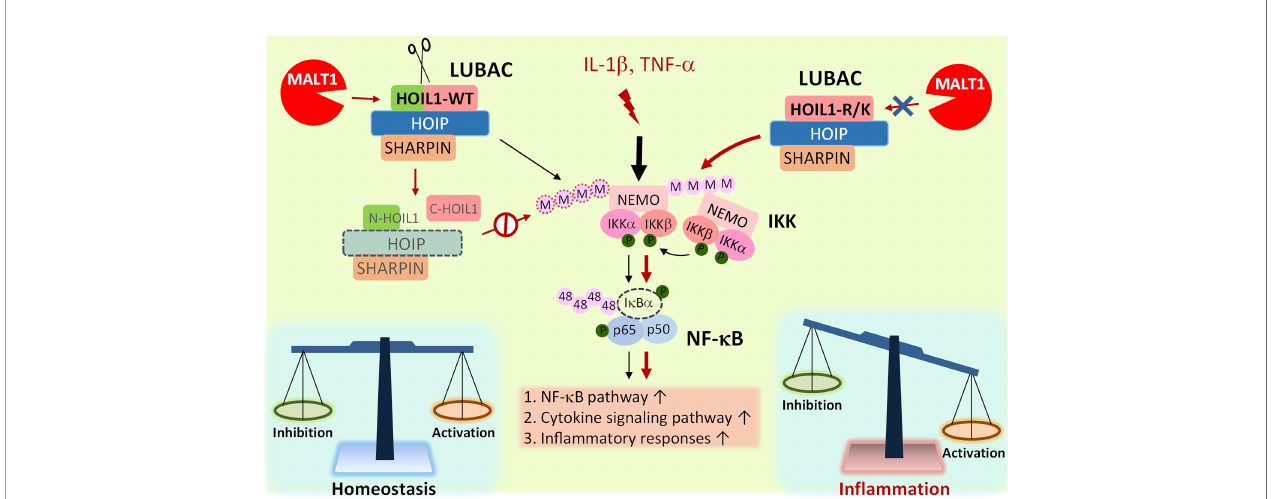
FIGURE 5 | Model of MALT1-mediated cleavage of HOIL1 and subsequent regulation of NF- k B and in fl ammation. Innate stimuli such as IL-1 b and TNF- a trigger LUBAC assembly and linear ubiquitination of various proteins such as NEMO (IKK g ) to promote the canonical activation of NF- k B. Over time, when a speci fi c signaling threshold has been reached, MALT1 proteolytically cleaves HOIL1 to disassemble LUBAC and decrease its activity to fi ne-tune NF- k B activation and restore homeostasis. In the absence of MALT1-dependent proteolytic regulation, as is the case in HOIL1-R/K and MALT1-de fi cient patients, NF- k B activation is sustained, leading to a shift towards a more proin fl ammatory phenotype in certain